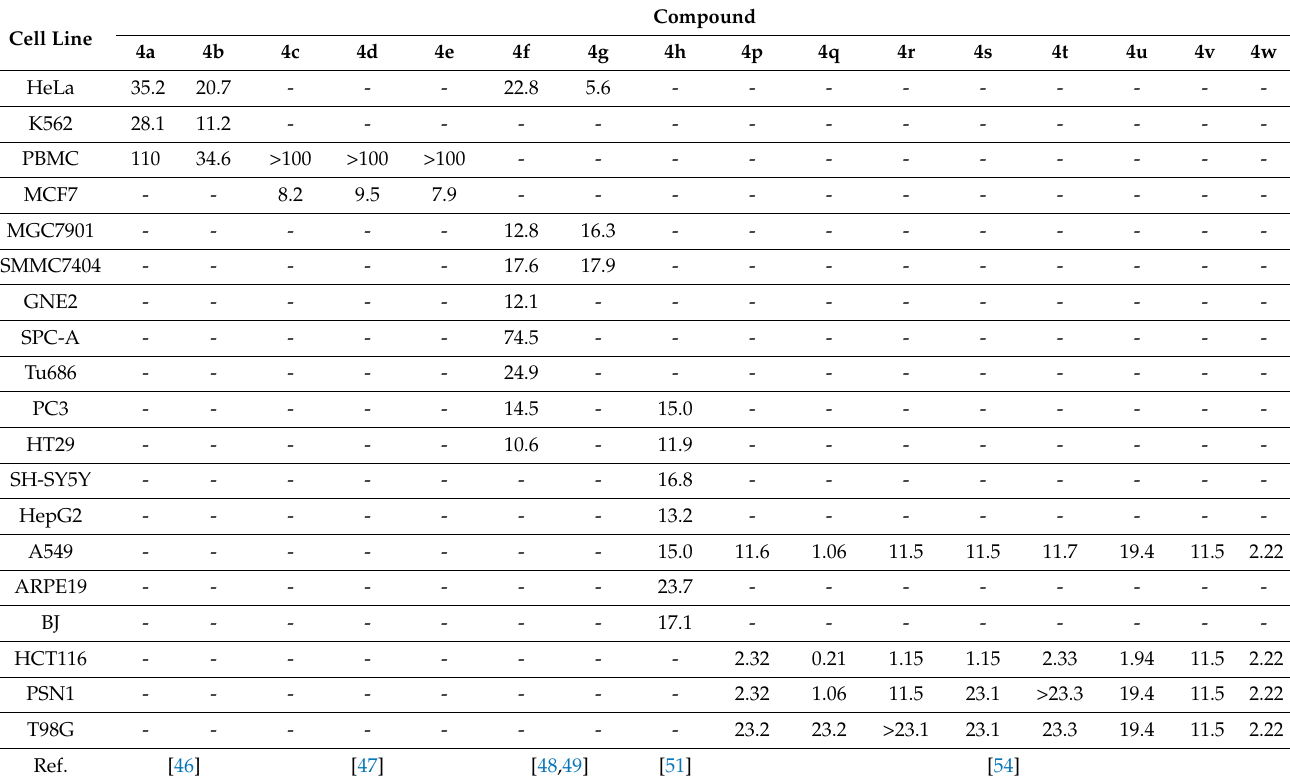
Table 5. IC 50 values (µg/mL) of the synthesized cholestane oxime derivatives (cont). cholesterol-containing hydroxyimino and lactam groups in the A/B ring with four